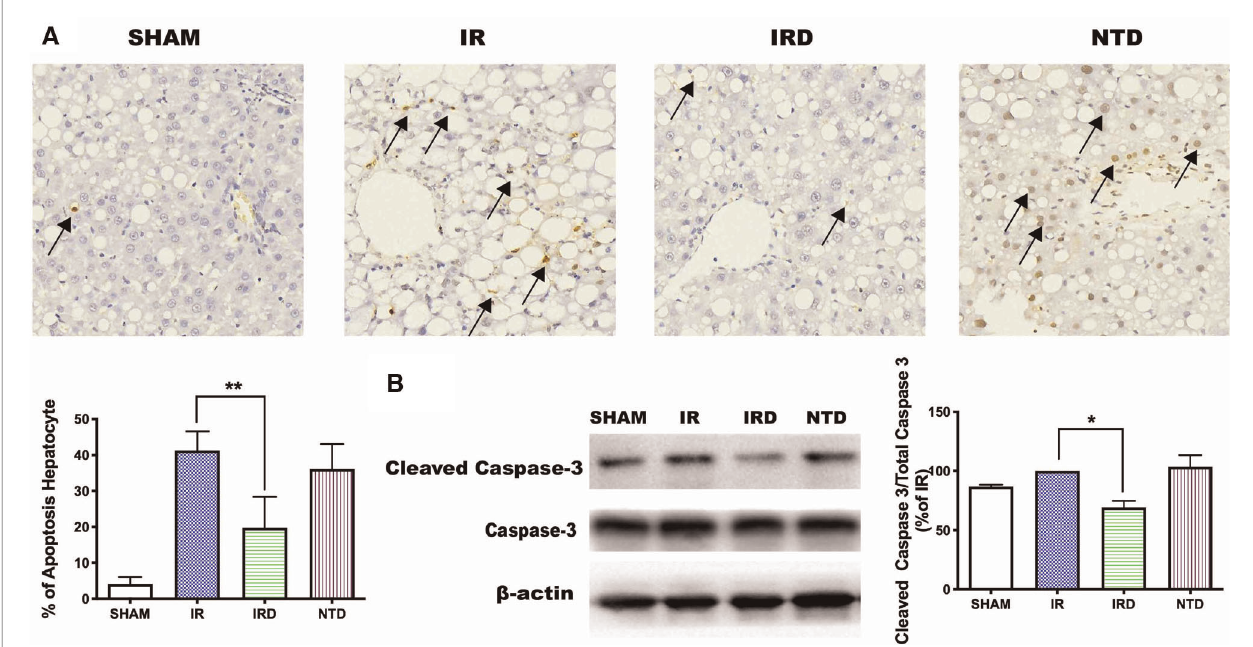
FIGURE 3 | DOR antagonist NTD eliminated the bene fi cial effect of DADLE. ( A ) TUNEL staining after 6 h reperfusion. Original magni fi cation 400×, n =6, * p <0.05 compared with the IR group, ** p <0.01 compared with the IR group. ( B ) The expression of cleaved Caspase-3 levels in each group after 6 h reperfusion; n =6, * p <0.05 compared with the IR group. IR, IRD, and NTD are the corresponding rat groups as in Figure 2 . The black arrow indicates the apoptotic liver